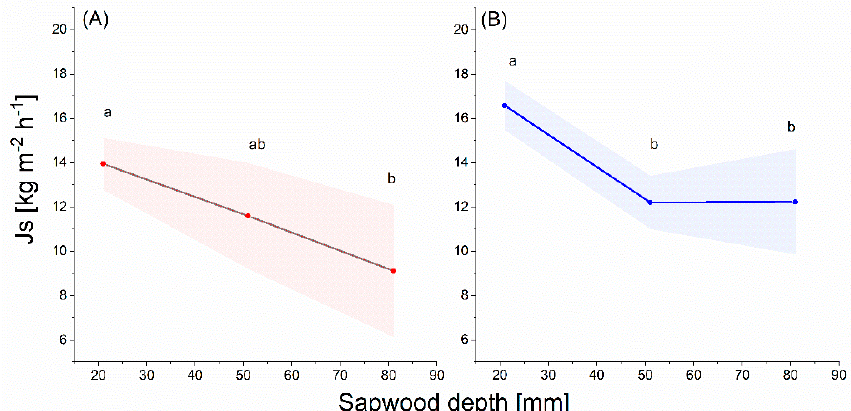
Figure 2. Variation of mean tree sap flux density (Js) with increasing radial sapwood depth during ( A ) the dry study period, and ( B ) the wet study period. Shaded bands represent ± SE of the mean ( n = 5 trees). Different letters indicate significant differences between the 3 sapwood depths.